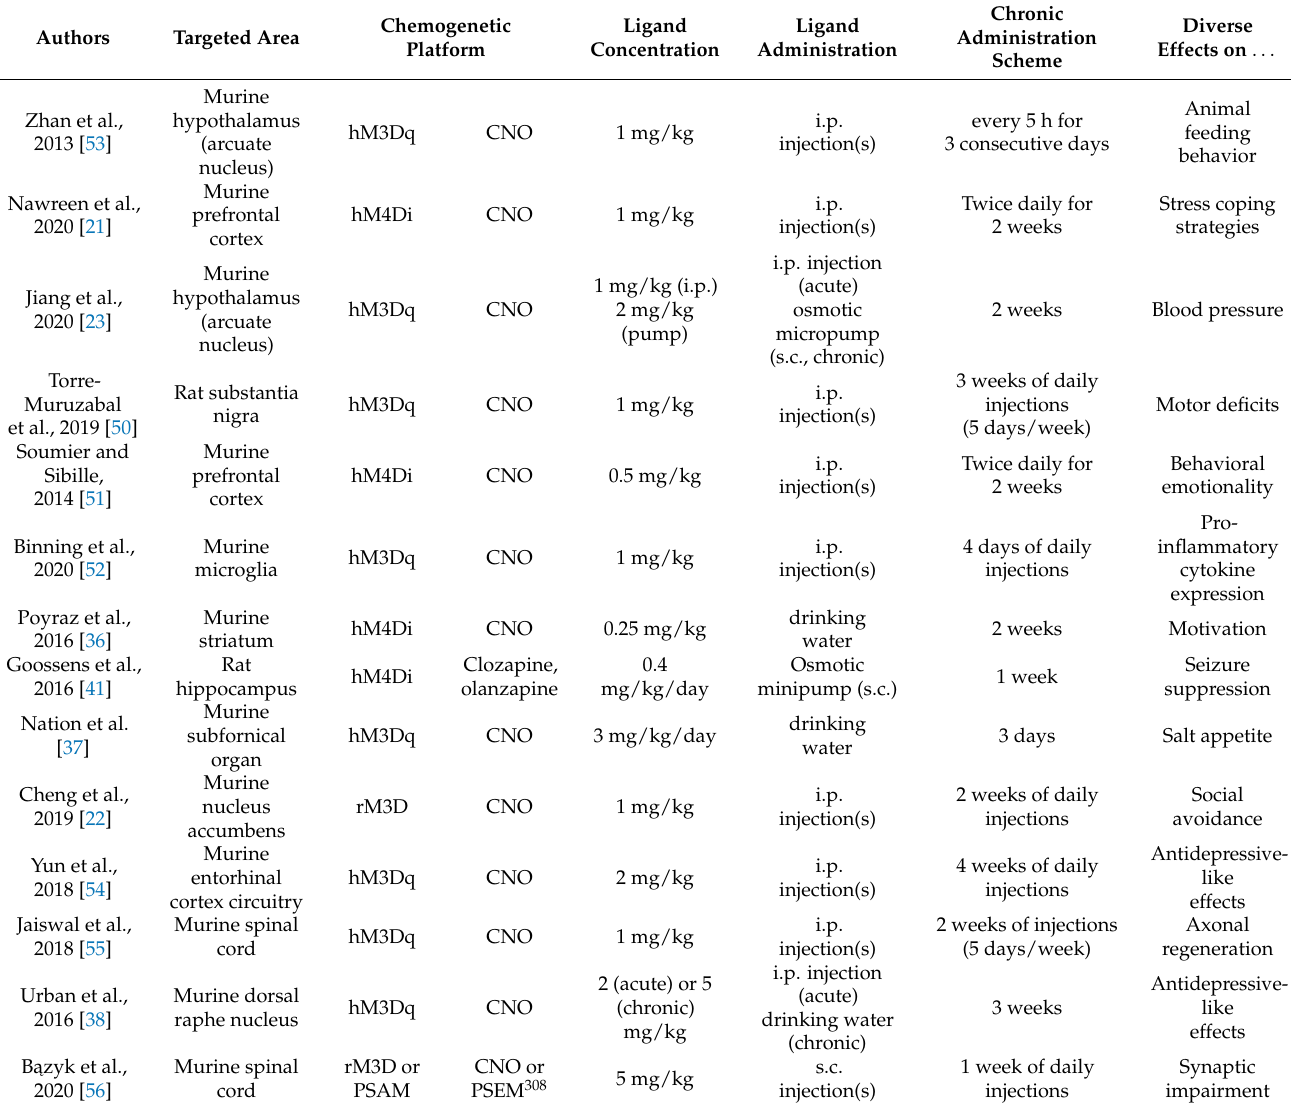
Table 1. Overview of DREADD studies in which diverse effects of acute versus chronic DREADD treatments have been